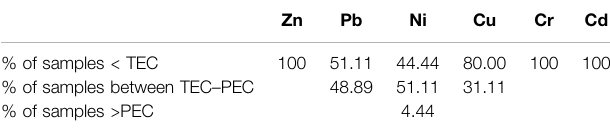
TABLE 7 | Comparison between sediment quality guidelines (SQGs) and heavy metal concentrations (mg/kg) of all samples in Jian and Moyang rivers. Zn Pb Ni